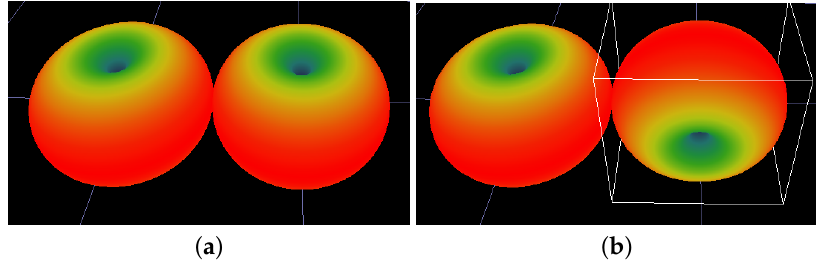
Figure 1. Typical antenna orientation set-ups: Part 1. ( a ) Tx-01 Vertical -Tx-02 Vertical; ( b ) Tx-01 Vertical -Tx-02 Horizontal 90deg.